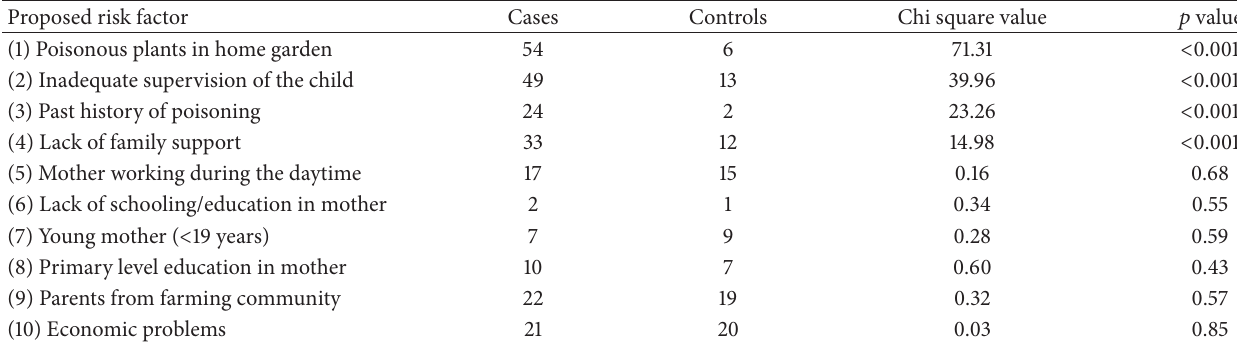
Table 5: Analysis of proposed risk factors in case-control